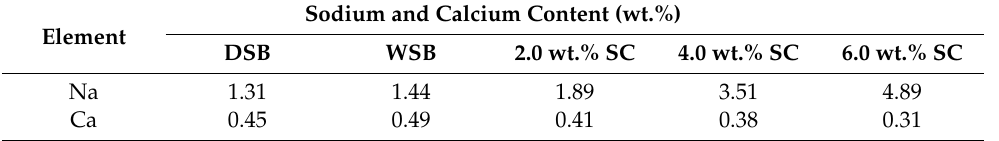
Figure 8. Pareto chart of the standardized effect for the CEC (A, Na 2 CO 3 concentration; B, temper- ature; C, time, L, linear and Q, quadratic).